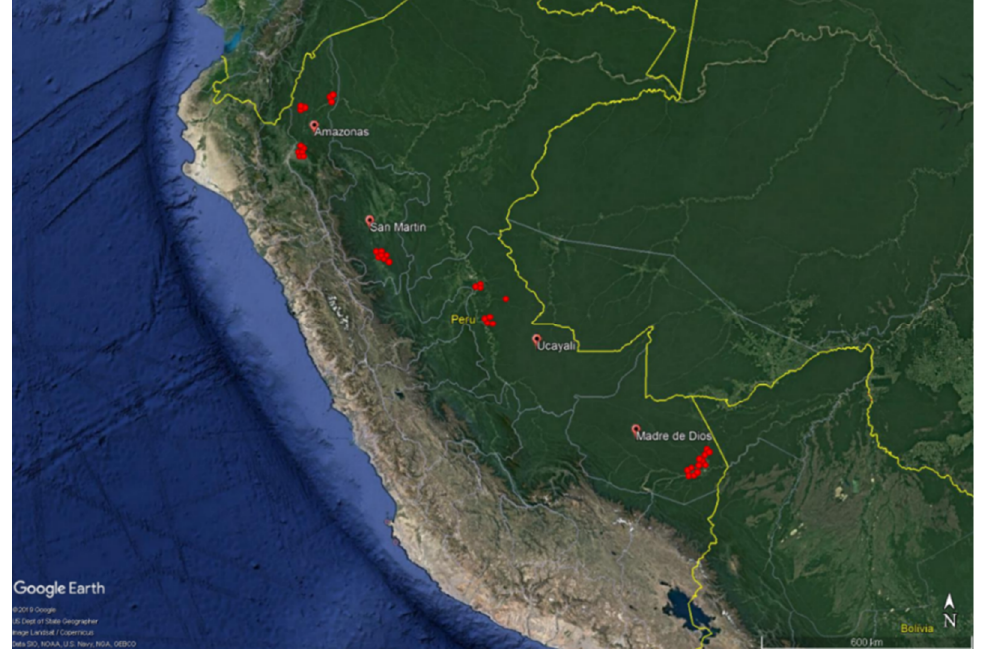
Figure 1. Location of the 40 study sites within the four study regions in Peru (Madre de Dios, Ucayali, San Martin, and Amazonas). Source: Google Earth.